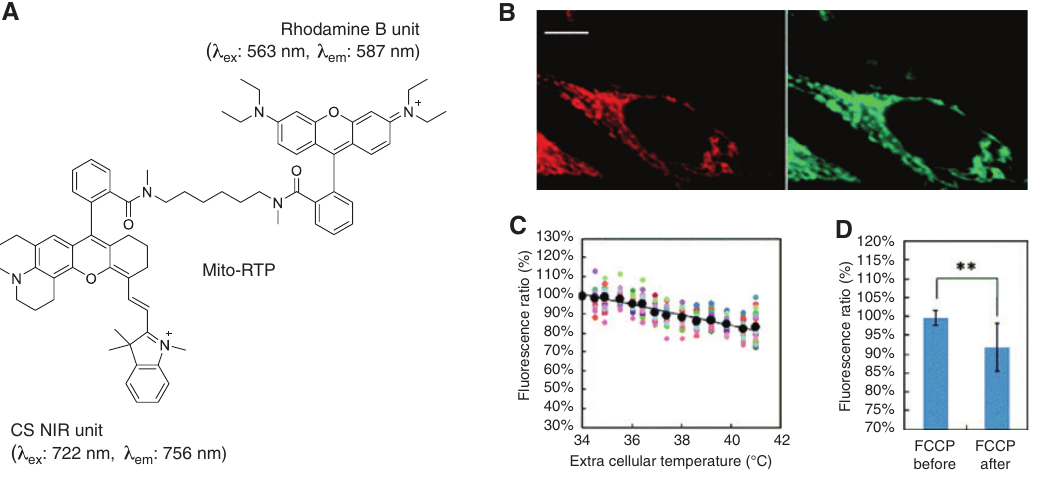
Figure 4: Measurement of mitochondrial temperature using Mito-RTP. (A) Chemical structure of Mito-RTP that consists of rhodamine B and CS NIR units. (B) Localization of Mito-RTP. Fluorescence images of Mito- RTP (left) and mito-tracker green (right). Scar bar = 5 μ m. (C) Temperature-dependent fluorescence intensity ratio (rhodamine B unit/CS NIR unit) of Mito-RTP in living HeLa cells. The colored and black markers represent individual measurements (n = 26) and their averages, respec- tively. (D) Change in the fluorescence intensity ratio as a function of chemical stimuli using FCCP. **p = 8.1 × 10 − 5 using Student’s t-test before (− 90 s) and after (330 s) addition of FCCP. Reproduced with permission from Homma et al. (2015). Copyright 2015 Royal Society of Chemistry.